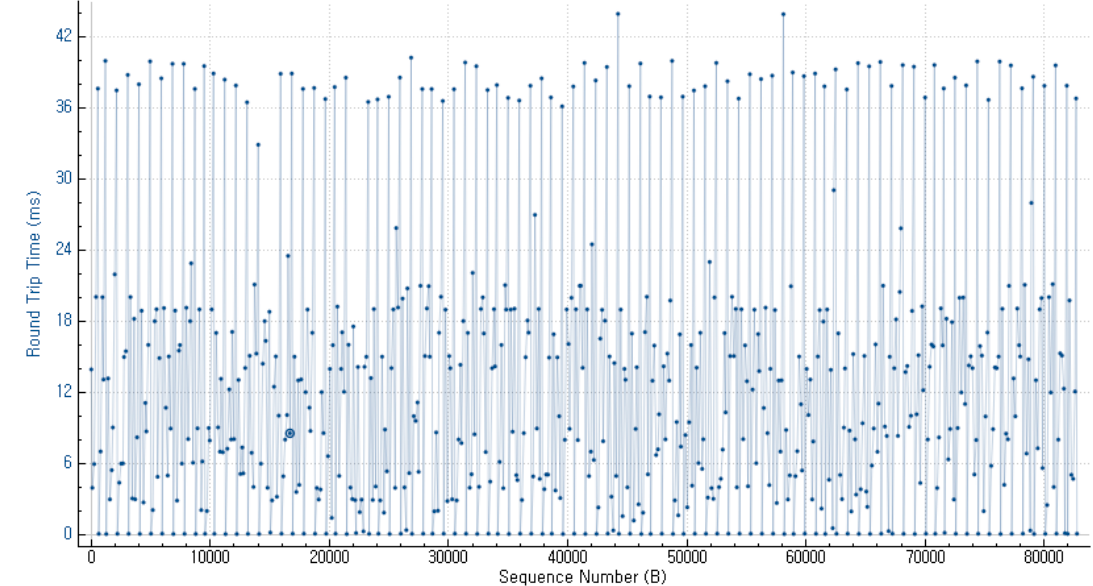
Figure 16. Round-trip time (OPC UA: UA Expert—OPC UA server module).